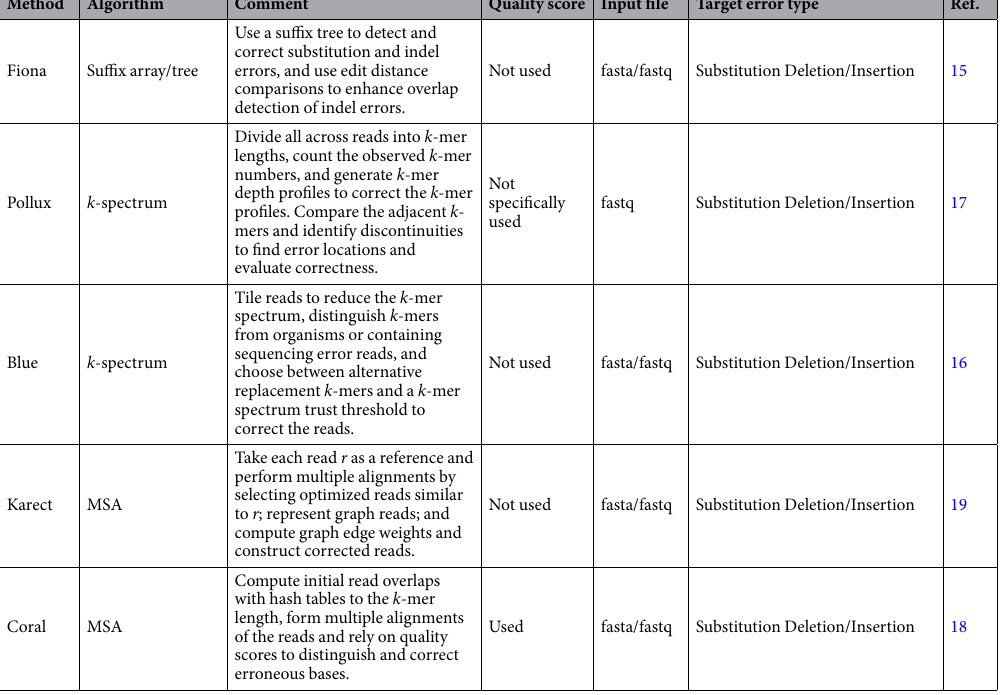
Table 1. Algorithms for error correction in Ion Torrent PGM